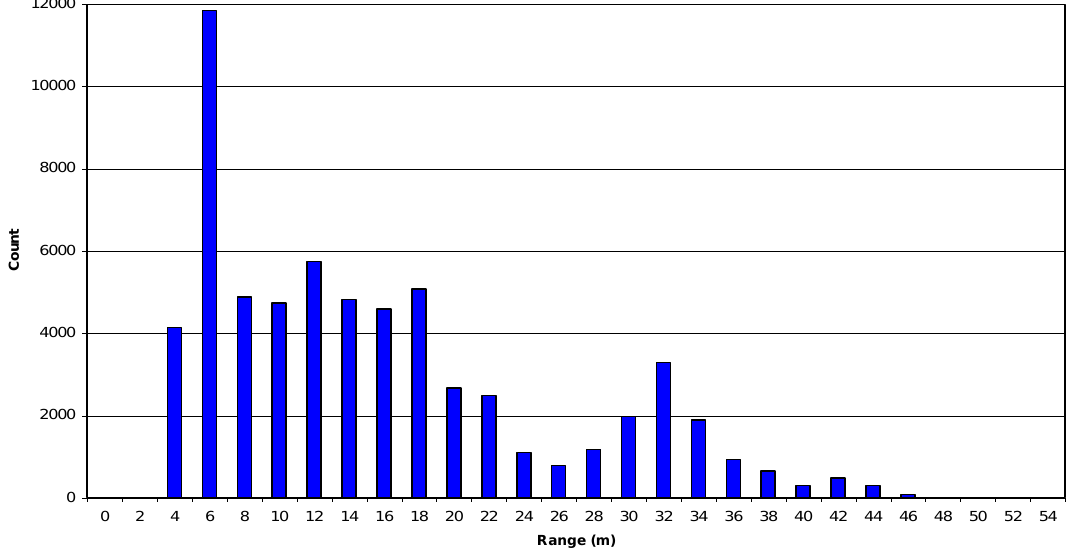
Figure 4. Histogram of Raw Range Measurements, Laser 1–Set 1. Histogram of Measurement Ranges, Laser 1 - Set